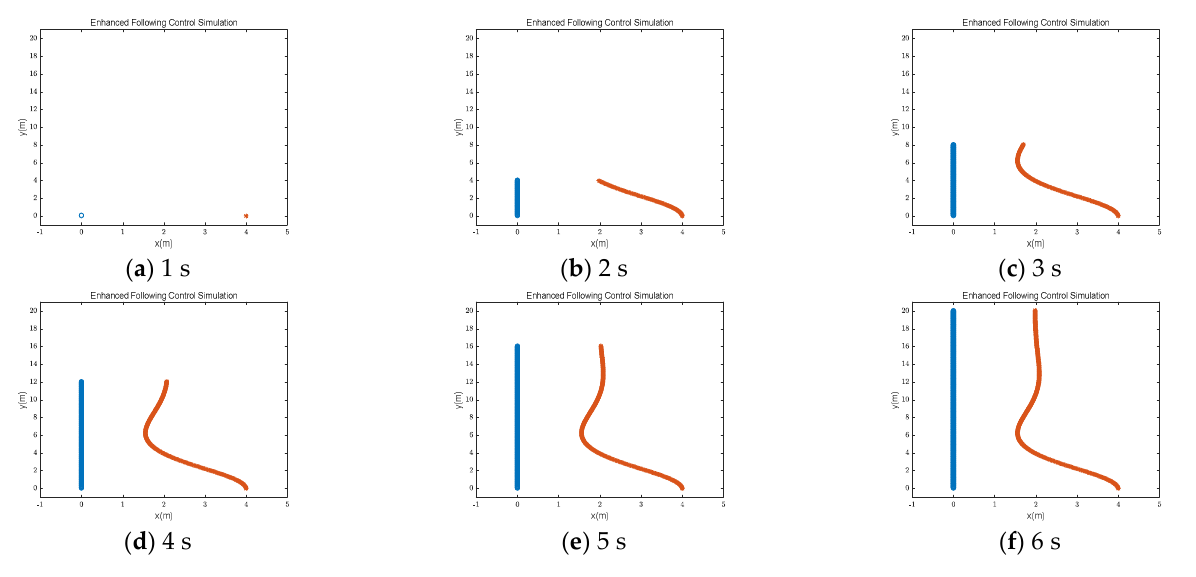
Figure 9. Enhanced following control simulation results ( = 10, = −1.117 , recorded every 1 s). The blue line is the trajectory of the leading vehicle and the red line is the trajectory of the following vehicle.